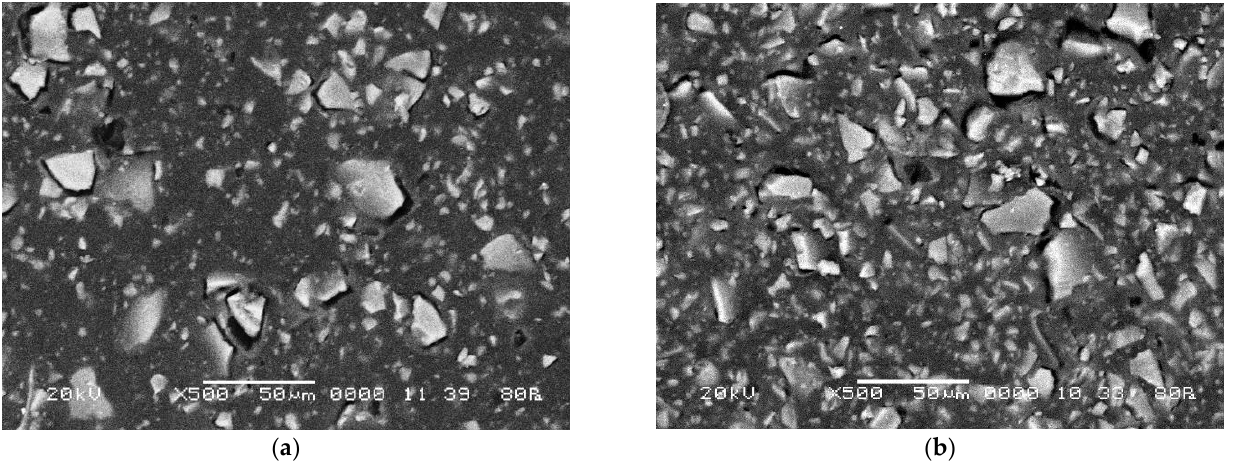
Figure 1. SEM images of the surface of swollen cation-exchange membranes at a magnification of 500. Ion-exchanger fraction: 45 ( a ), and 65 ( b ) wt%.